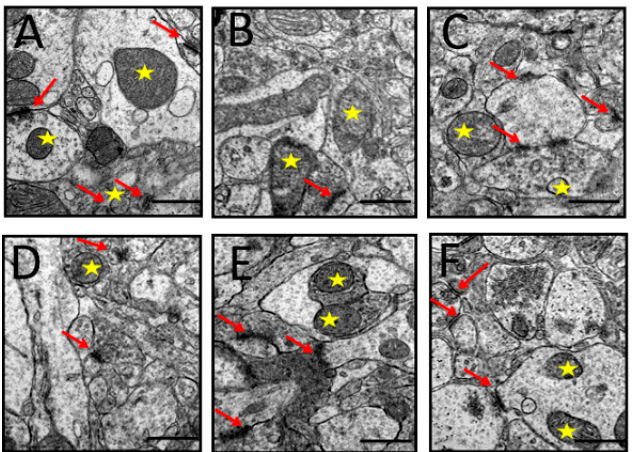
and AlCl 3 and those co-administered with donepezil and CA. ( A ) Control group: Showed synaptic